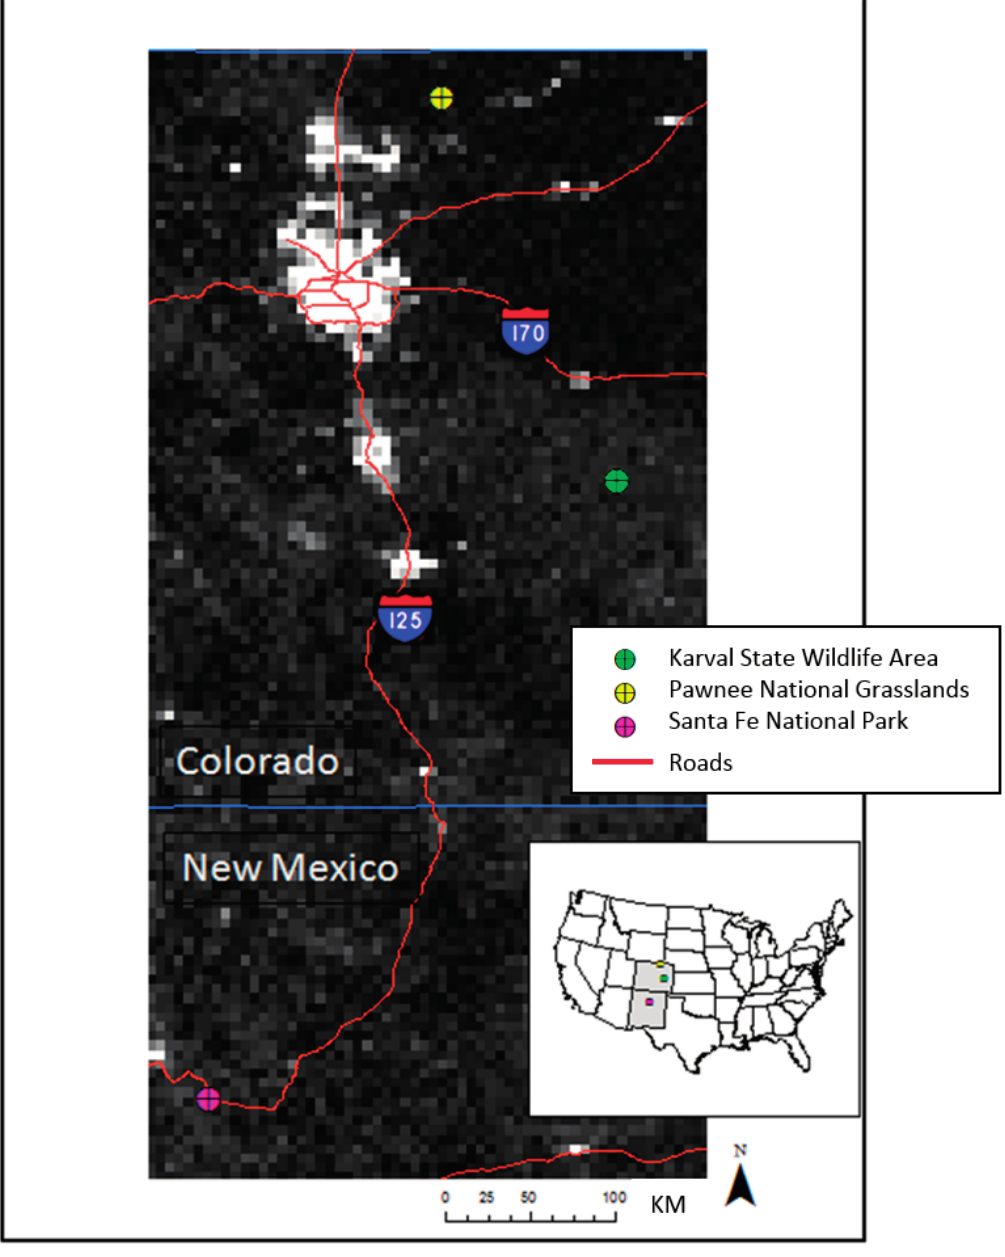
Figure 3. Map of the three field sites in Colorado and New Mexico with a nighttime lights annual composite from satellite F16 for the year 2009 as the